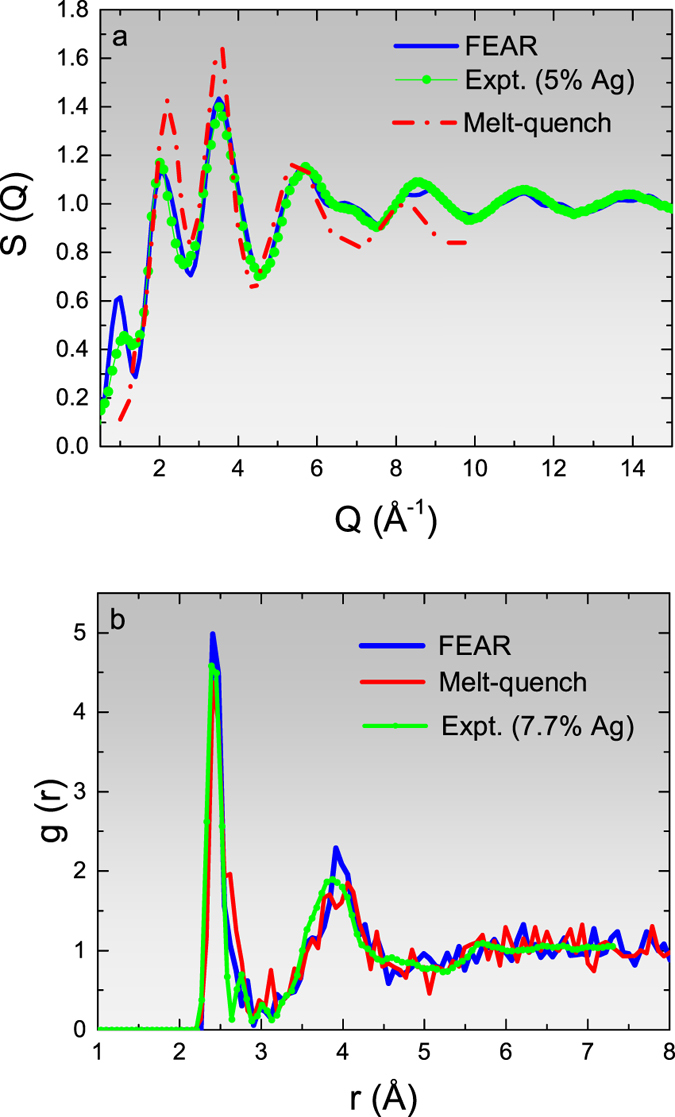
(a) Structure factors of (GeSe3)1−xAgx [x = 0.05] from AIFEAR. Experimental data, from neutron diffraction measurements, are shown for comparison29. Melt-quench data are from Pradel et al.29 (b) The radial distribution function of (GeSe3)1−xAgx [x = 0.077] from AIFEAR and melt-quench simulations. Experimental RDF shown here are from Zeidler et al.30.